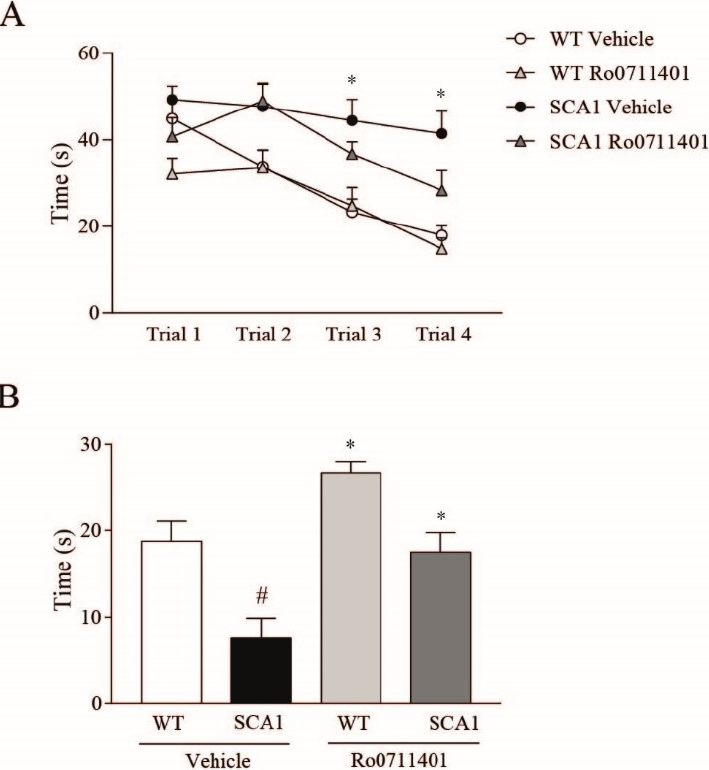
Figure 3. Treatment with the mGlu1 receptor PAM, Ro0711401, improves learning and memory in 8-week-old SCA1 mice. Spatial learning and memory retention in 8-week-old SCA1 mice and wild-type littermates are shown in ( A ) and ( B ), respectively. * p < 0.05 SCA1 vehicle vs. the respective values obtained in wild-type mice in ( A ). * p < 0.05 vs. SCA1 vehicle; # p < 0.05 vs. the respective values obtained in WT mice treated with vehicle in ( B ). Statistical analysis was performed by two-way ANOVA for repeated measures + Bonferroni test in ( A ) and two-way ANOVA + Bonferroni test in ( B ). Values are means ± SEM of 7–10 mice. In ( A ): interaction, F 9,93 = 2.71, p = 0.0076; time, F 3,93